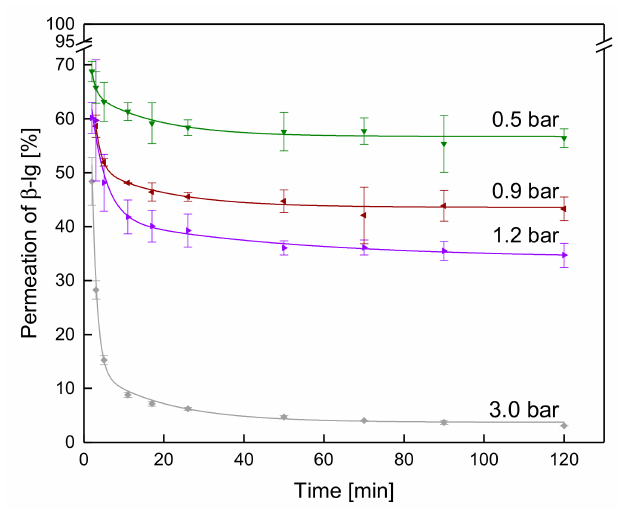
Figure 7. Permeation of β -lg as a function of time at di ff erent ∆ p TM values at 10 ◦